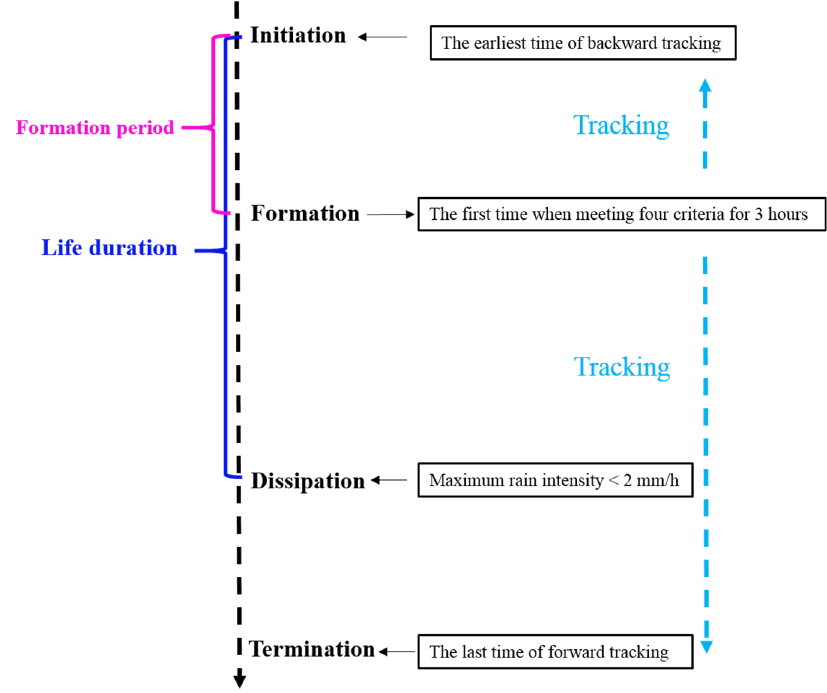
Figure 3. Flow diagram showing the procedure for the identification and tracking of MCSs.